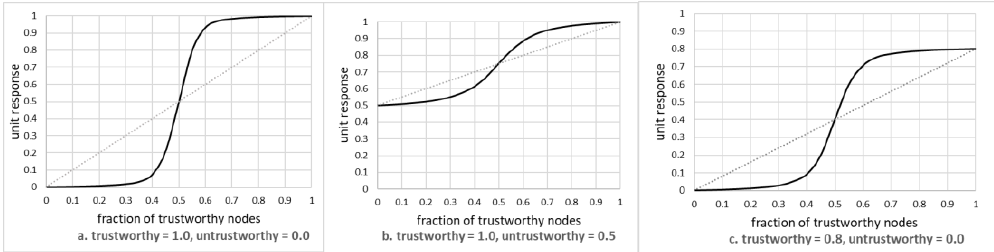
Figure 4. Unit response as a function of the fraction of trustworthy nodes.